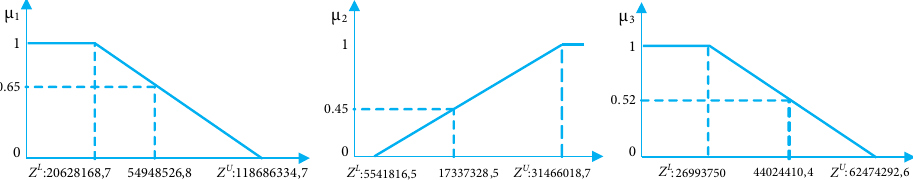
Fig. 6. Optimal objective values and membership function values for the new lower level satisfaction